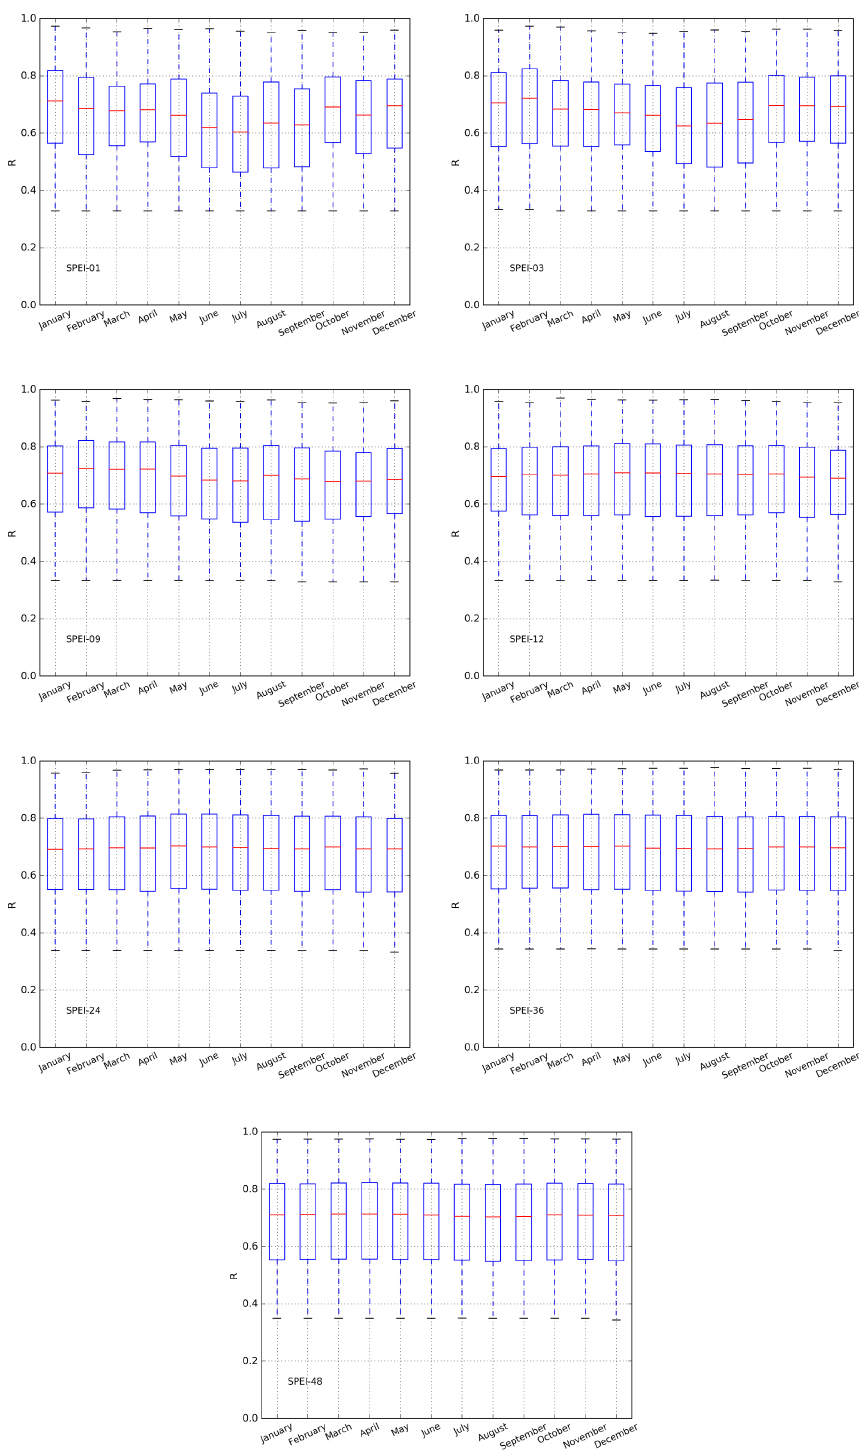
Figure A1. Box plots of the correlation ( p < 0 . 05) between SPEI-HR and SPEI-CRU for each month and the entire monthly record.